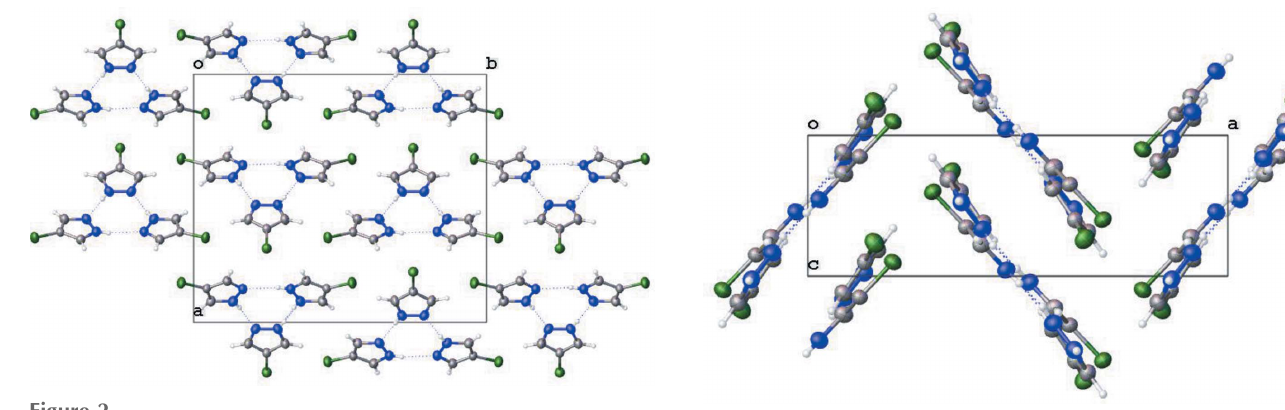
Figure 3 Packing of 4-chloro-1 H -pyrazole, viewed parallel to the b axis, showing the formation of a herringbone